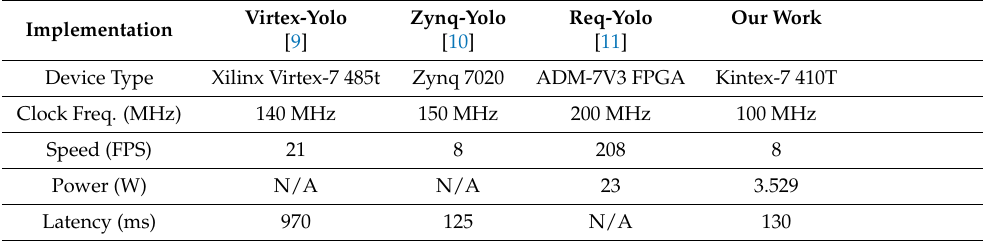
Table 5. Benchmarking with state-of-the-art object detection using FPGA accelerators.